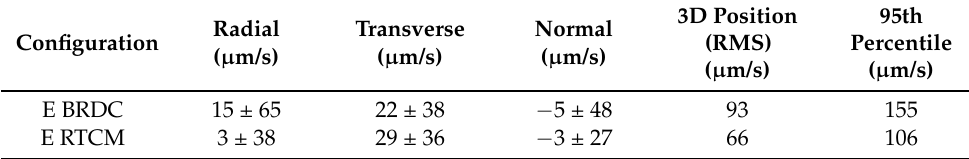
Table 4. Velocity difference statistics for 24–30 September 2021. For each configuration, the difference is computed with respect to the CNES-POD solution. For the individual axes (RTN frame), the mean values ± standard deviation of the differences are provided. The 95th percentile is calculated for the velocity (3D) differences. The filter transient is not included.